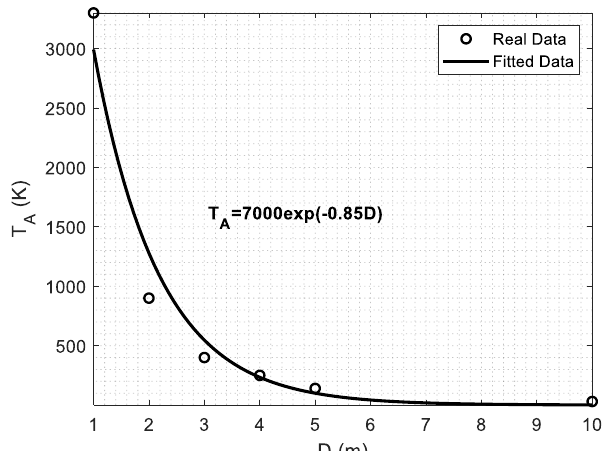
Figure 8: Peaks of antenna temperature (T